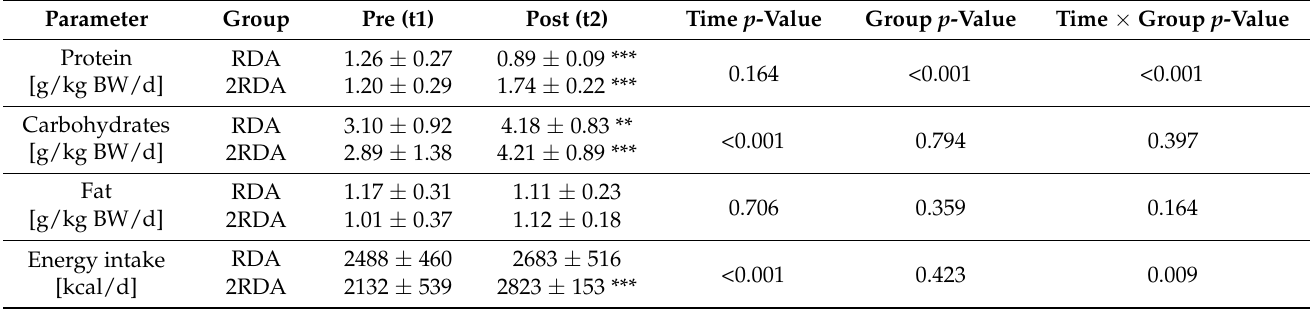
Values are shown as mean ± stdv. p -values refer to main effects of time and group as well as time*group interactions(two-way mixed ANOVA). Significant effects ( p < 0.05) are shown in bold. In case of significant overall time effects, Bonferroni-corrected post hoc analyses were performed individually for groups, whereby asterisks indicate significant differences to pre (t1). *** ( p < 0.001); ** ( p < 0.01). RDA (Recommended Daily Allowance for protein, 0.8 g/kg BW/d).